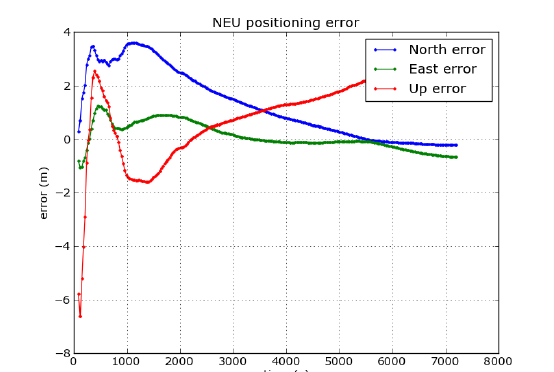
Figure 3: Positioning errors for G only observation processed by gLAB software